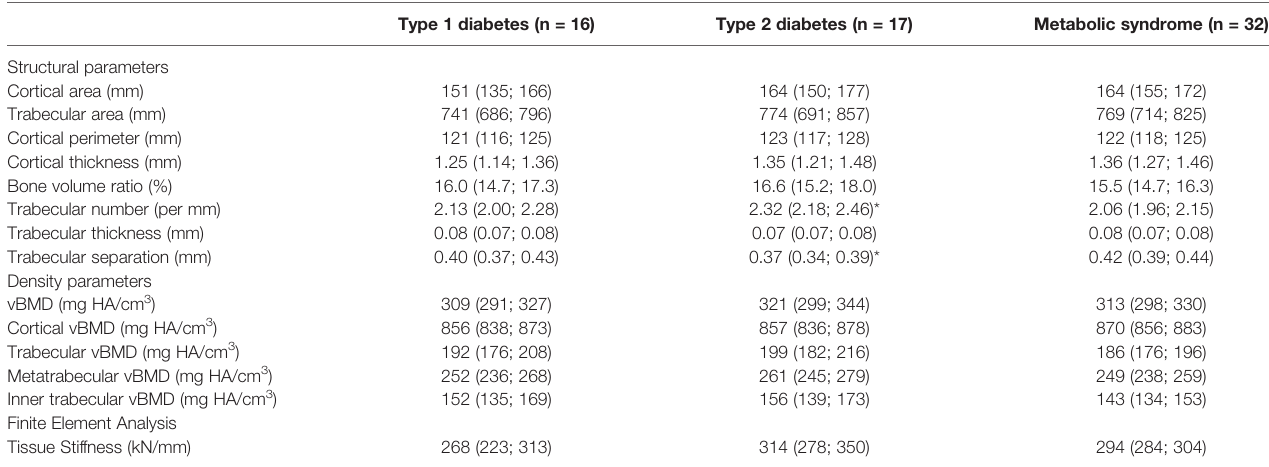
TABLE 2 | Results from high resolution peripheral quantitative CT of the